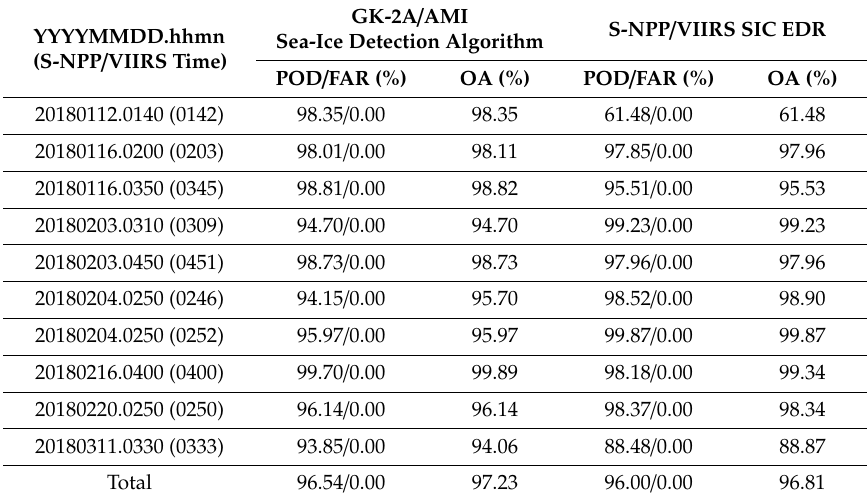
Table 2. Comparison result of GK-2A / AMI sea-ice detection algorithm, S-NPP / VIIRS SIC using sea-ice ROI data for 10